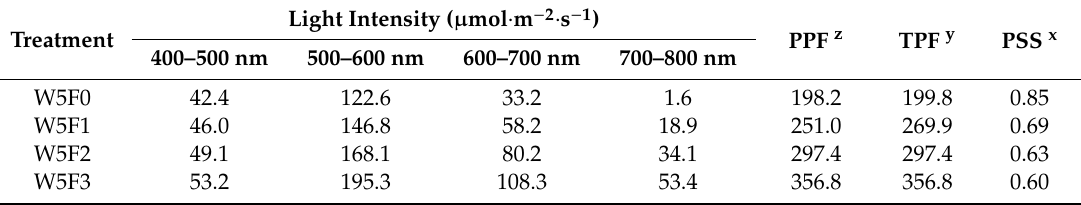
Table 1. Lightintensityandphytochromephotostationarystatevaluesofsupplementalfar-red-enrichedlights. Treatment